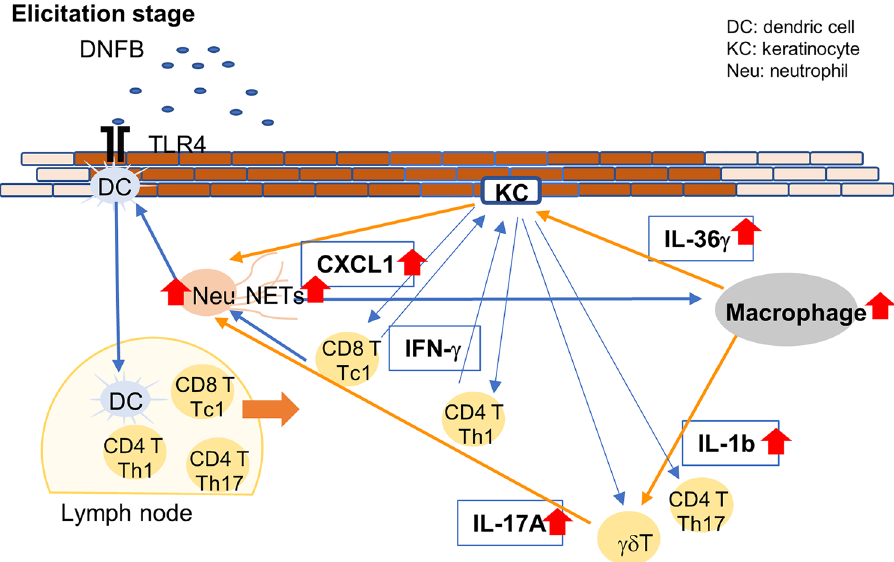
Figure 5. Scheme illustrating the pathology of contact hypersensitivity lesions in the elicitation phase. In Il36rn −/− mice, the enhancement of NET formation promoted the production of cytokines, such as interleukin (IL)-36γ and IL-1β, by macrophages. IL-1β may induce IL-17A production from γδ T cells and contribute to neutrophil generation. In addition, IL-36γ stimulation may induce keratinocyte activation, and C-X-C motif chemokine ligand (CXCL) 1 produced by keratinocytes may induce the migration of neutrophils, CD4 + T cells, CD8 + T cells, and γδ T cells, further promoting neutrophil generation. KC, keratinocyte; DC, dendritic cell; NETs, neutrophil extracellular traps; Neu, neutrophils. γδ T: γδ T